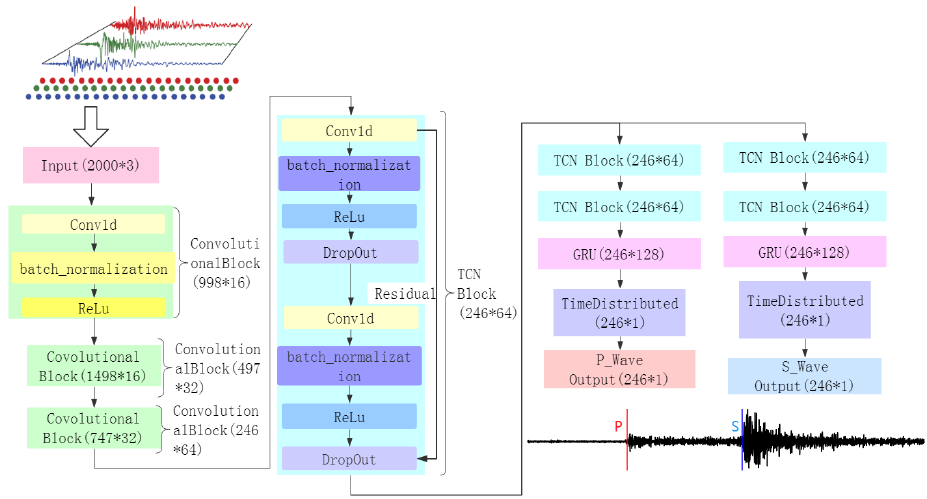
Figure 9. A network structure diagram of our S-TCN